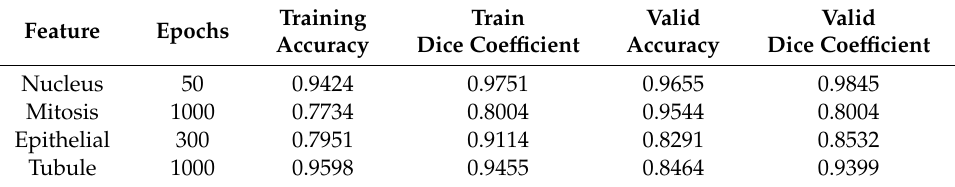
Table 1. Results on the training of U-net models.